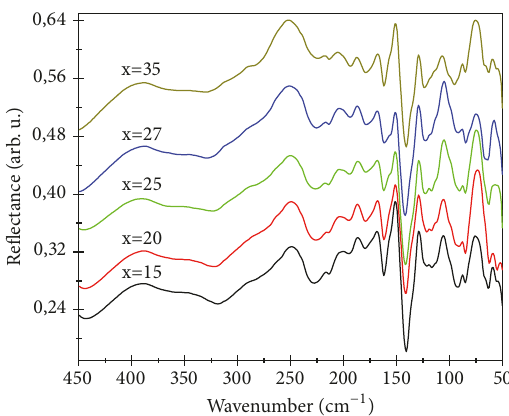
Figure 6: Far FTIR reflectance spectra of Ge x Sb 40 different x